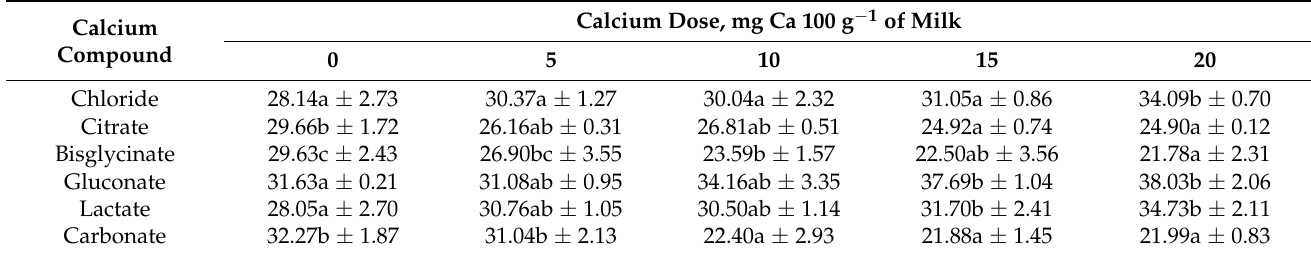
Table 5. Syneresis (%) of acid rennet goat’s milk